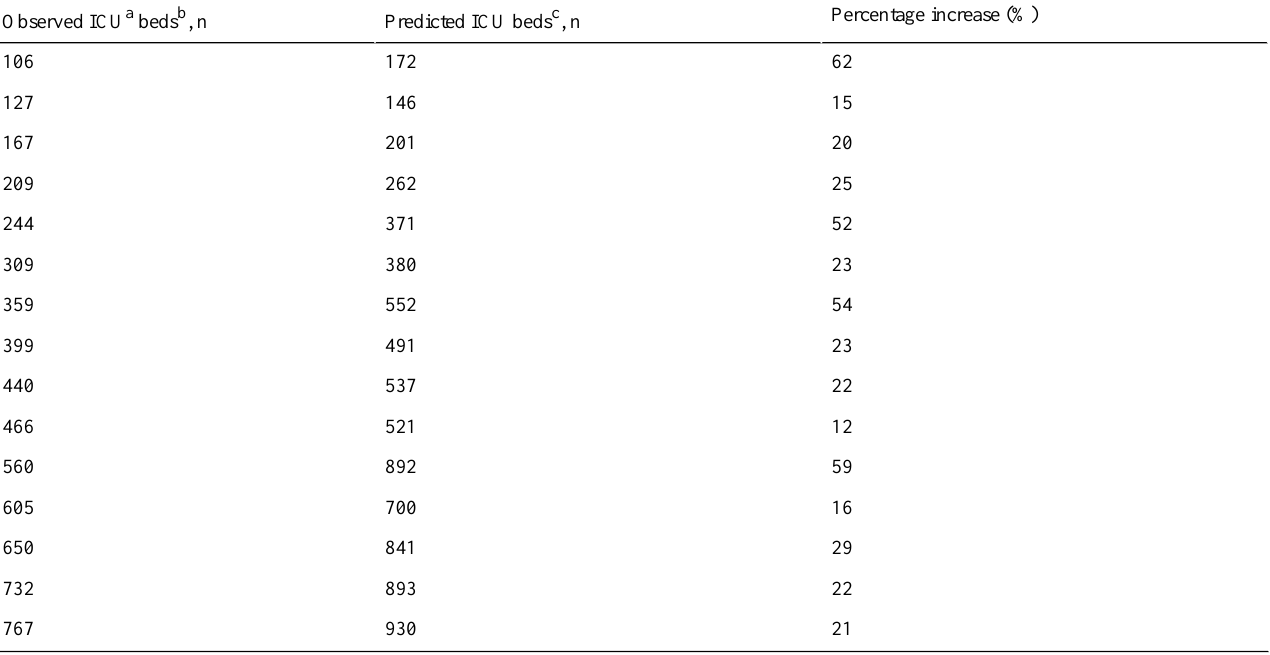
Table 2. Observed versus predicted ICU beds for the Lombardia Region for each time window (W1, ..., W15) considered in the time period from February 24 to March 15, 2020.